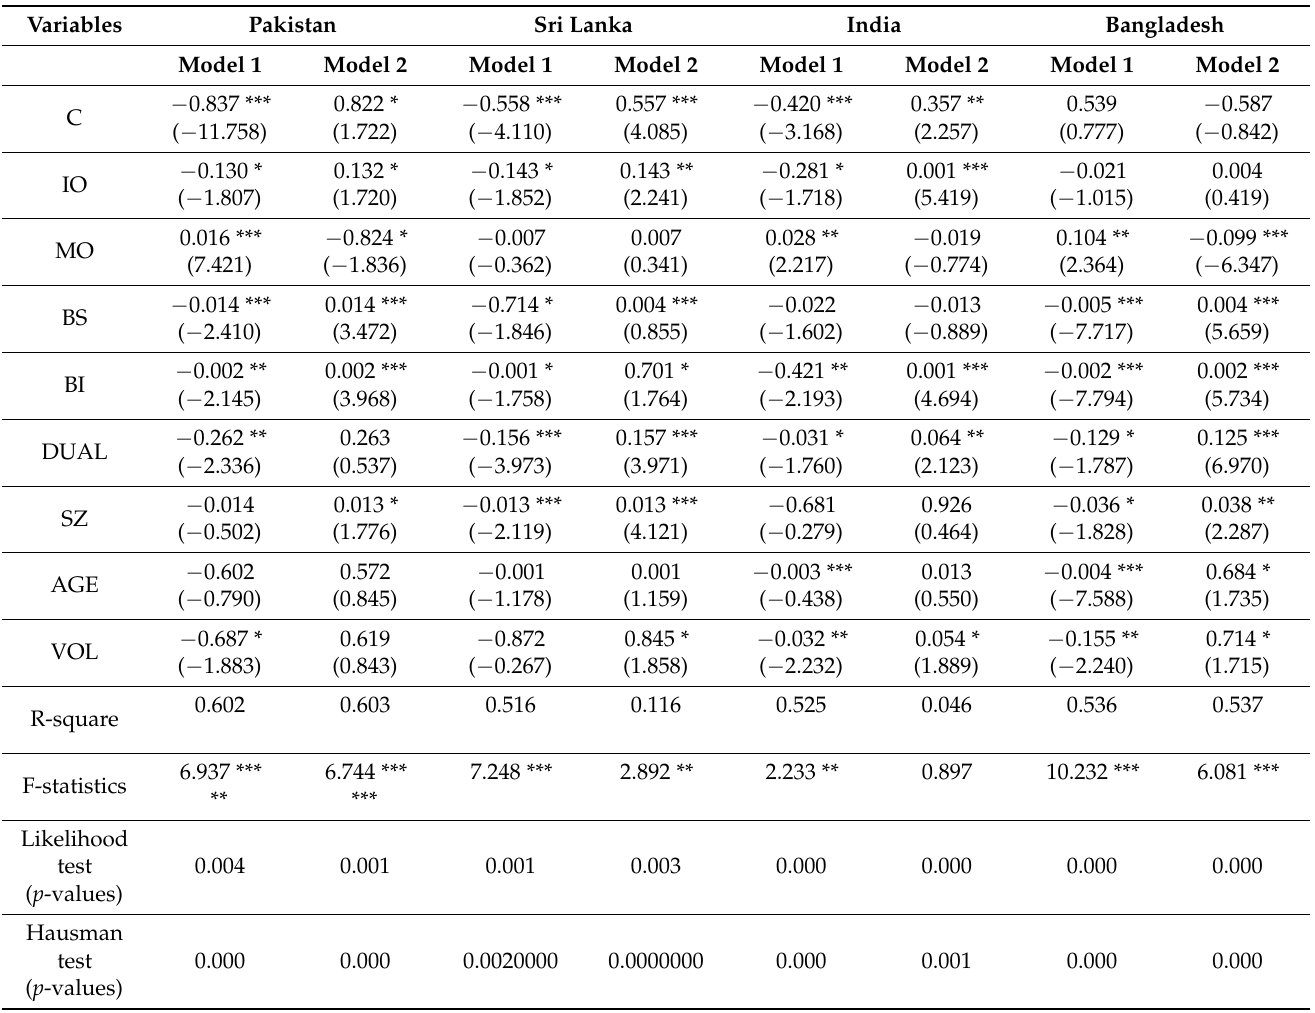
Table 5. Fixed effect model (country-wise